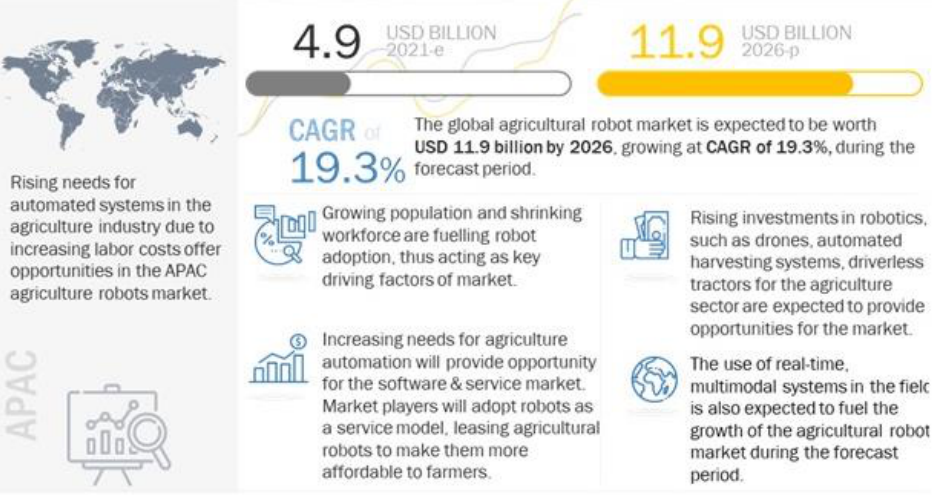
Figure 5. The current state of the global swarm robotics market [109].